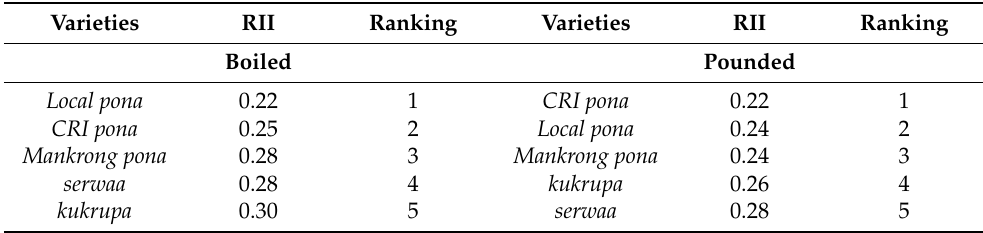
Table 4. Relative index for choice of yam variety for overall acceptability of boiled and pounded yam ( D. rotundata